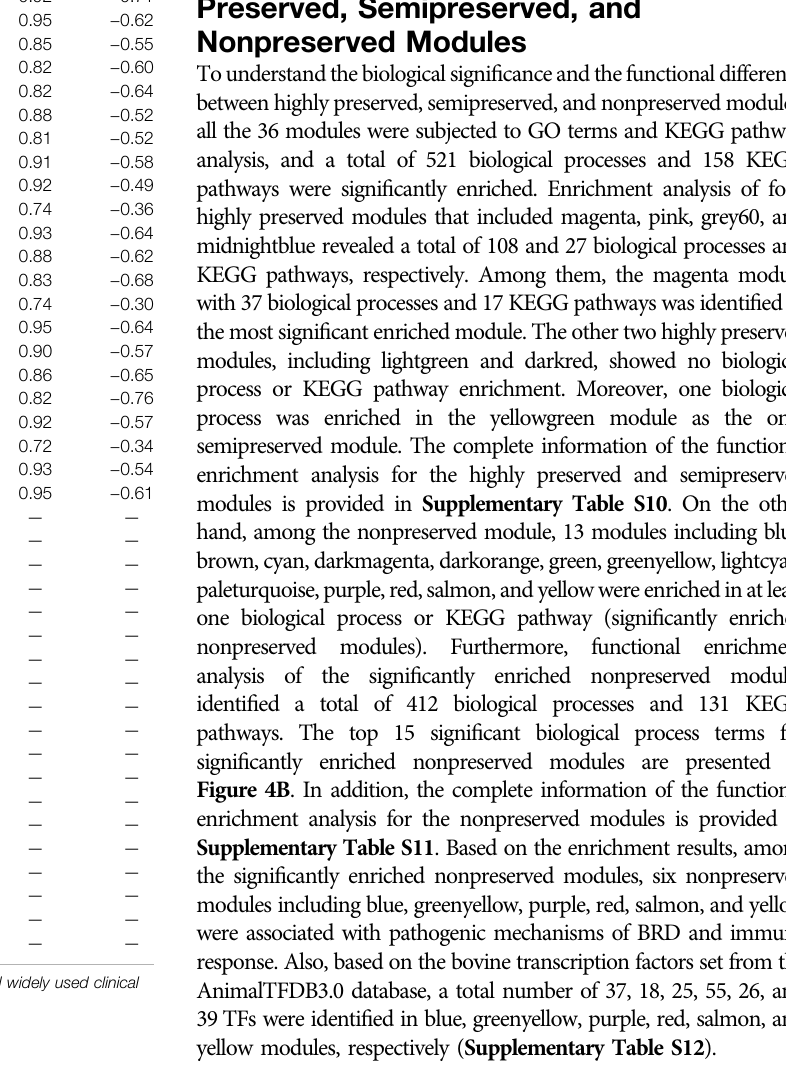
Supplementary Table S11 . Based on the enrichment results, among the signi fi cantly enriched nonpreserved modules, six nonpreserved modules including blue, greenyellow, purple, red, salmon, and yellow were associated with pathogenic mechanisms of BRD and immune response. Also, based on the bovine transcription factors set from the AnimalTFDB3.0 database, a total number of 37, 18, 25, 55, 26, and 39 TFs were identi fi ed in blue, greenyellow, purple, red, salmon, and yellow modules, respectively ( Supplementary Table S12 ).